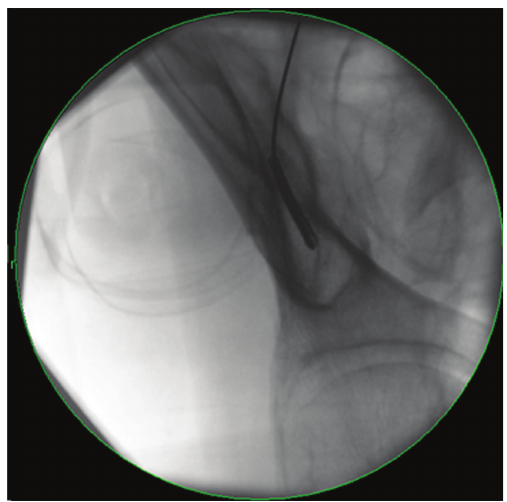
Figure 1: Obturator outlet view showing the “teardrop” target for iliac screw placement. Cannulation of this space provides a safe corridor completely within the bony confines.